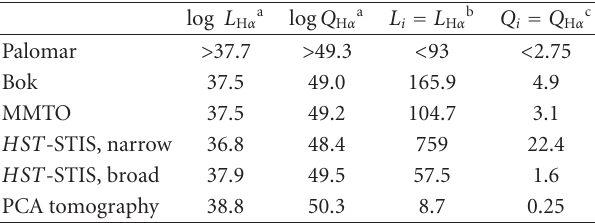
Table 4: Ionizing and emission-line